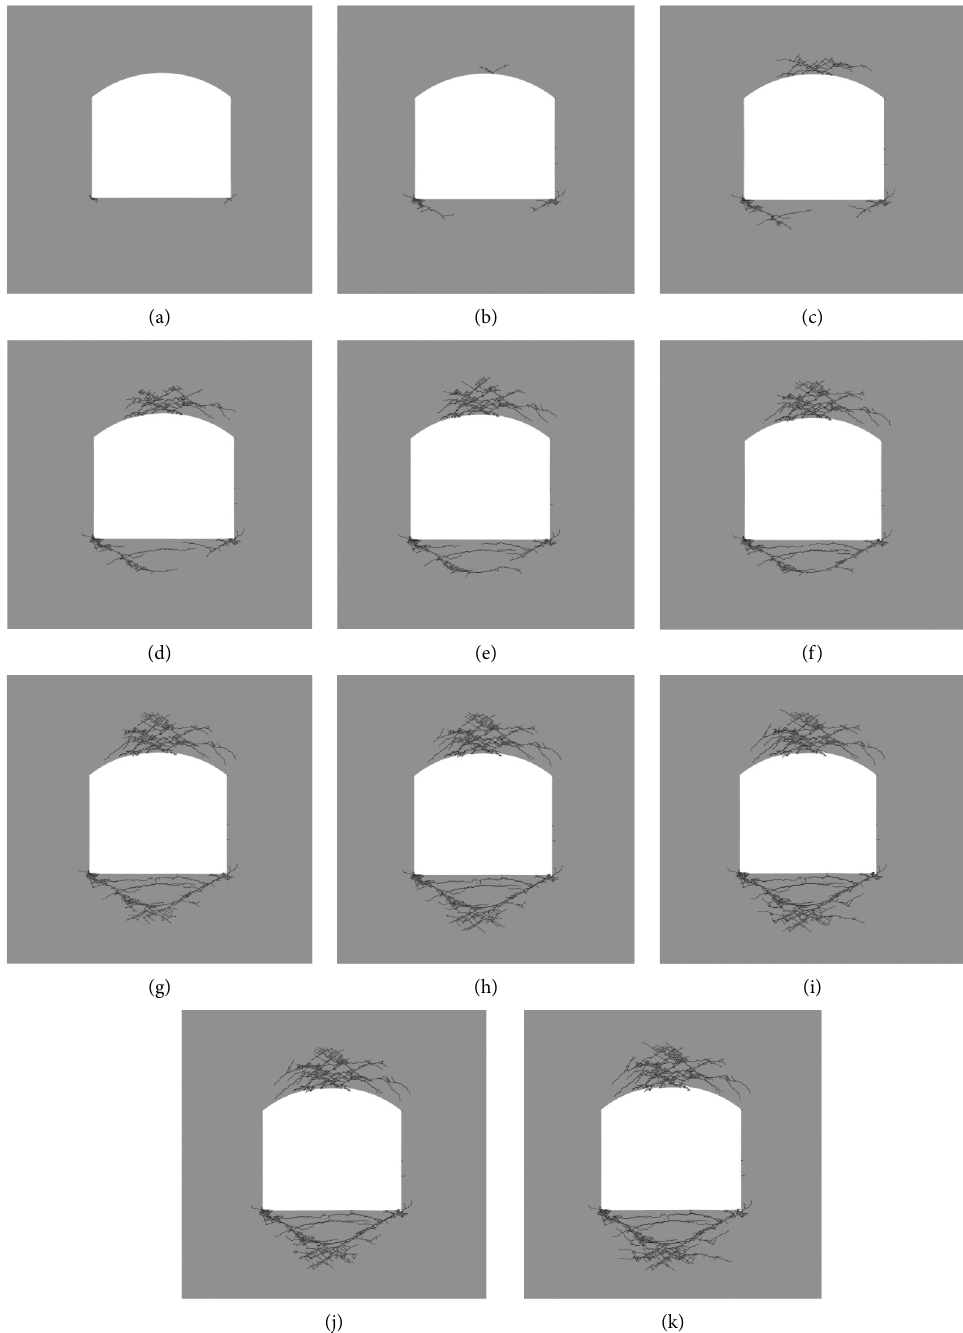
Figure 6: The evolution of cracks in PD62-2: (a) 825100, (b) 826100, (c) 827100, (d) 828100, (e) 829100, (f) 830100, (g) 831100, (h) 832100, (i) 833100, (j) 834100, and (k)